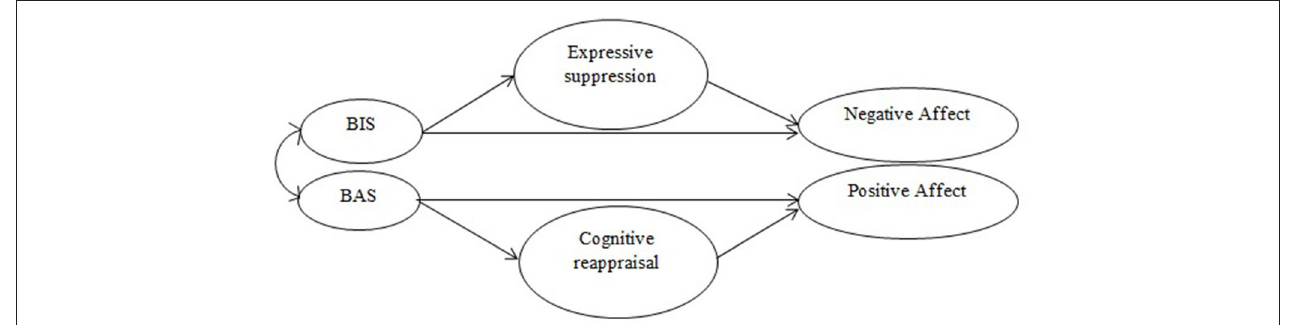
FIGURE 1 | Graphic representation of the study